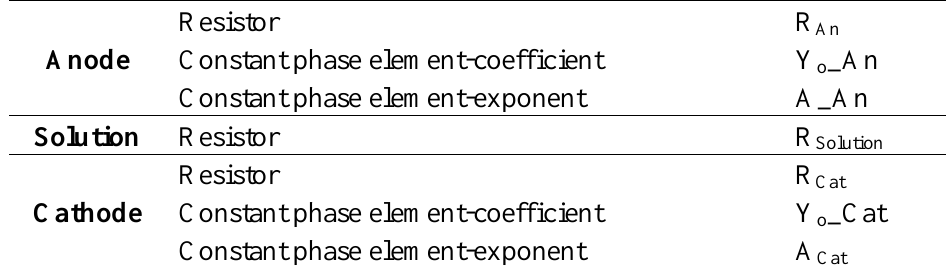
Table 1. Summary of components of ECM and associated regions of MFC.